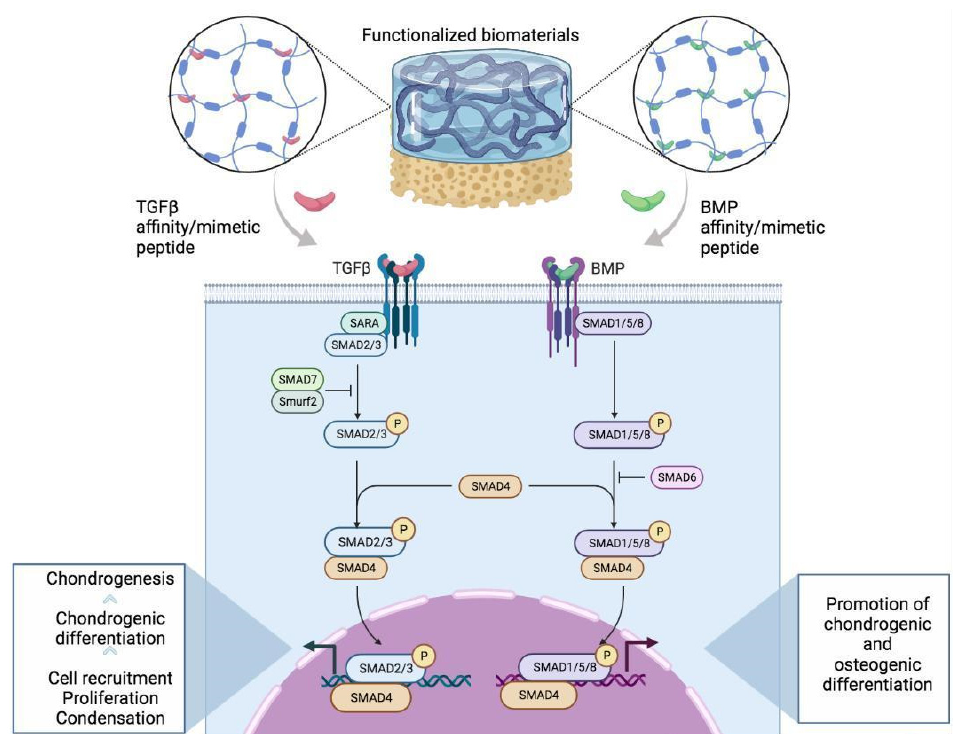
Figure 2. Representative scheme illustrating the molecular mechanisms of transforming growth factor beta (TGF β ) and bone morphogenetic protein (BMP) signaling-derived chondro- and osteoinductive peptides through the activation of SMAD-dependent signaling to induce/promote the chondrogenesis and/or osteogenesis of